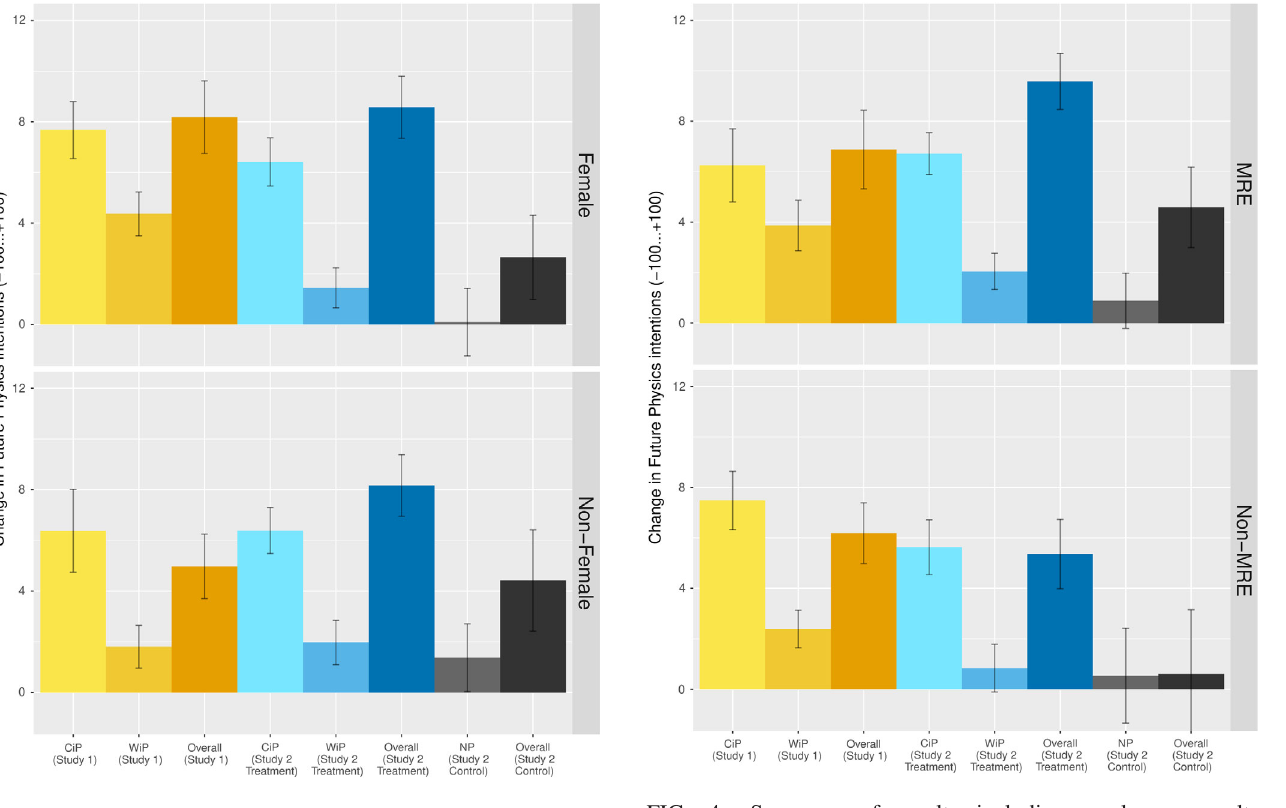
FIG. 3. Summary of results including per-lesson results (Careers in Physics, Women in Physics, and Notable Physicists lessons, in addition to the overall impact on students), female- identified students on top, nonfemale identified students on bottom. For each lesson (CiP, WiP, or NP), the bar represents the immediate post- minus immediate prescore. For the overall measure, the bar represents the latest post- minus prescore. Error bars represent standard errors.